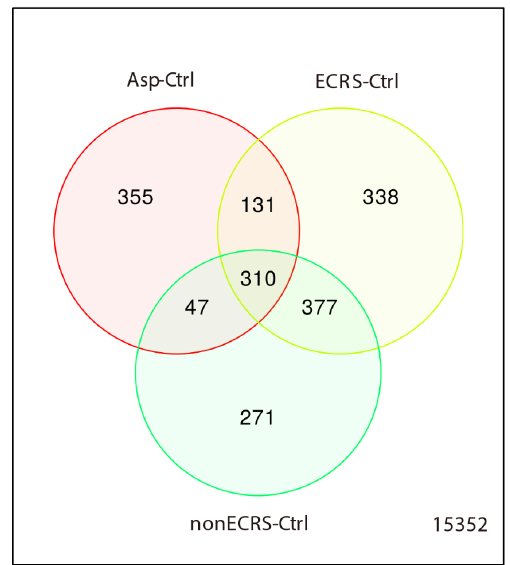
Figure 4. Venn diagram of all CRSwNP groups vs control. Specific DEGs were identified in each CRSwNP group as ECRS-Ctrl of 338, nonECRS-Ctrl of 271, and Asp-Ctrl of 355. Pathway analysis with the GO molecular function with DEGs in ECRS-Ctrl, nonECRS-Ctrl, and Asp-Ctrl showed the existence of significant up and downregulated pathways (Figure 5A–C), but Asp-nonECRS and Asp-ECRS showed no significant up and downregulated pathways.